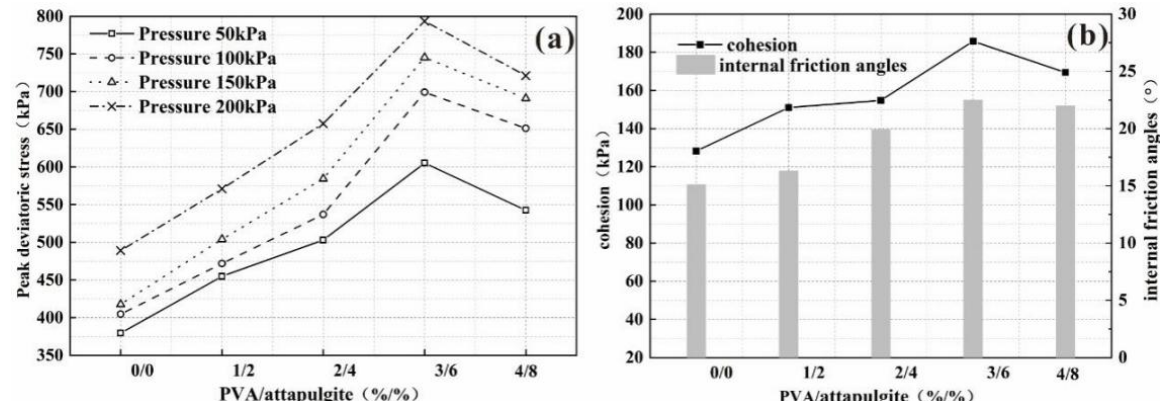
Figure 7. ( a ) The peak deviator stress curve; ( b ) cohesion and internal friction angle curve with different PVA content and attapulgite replacement.